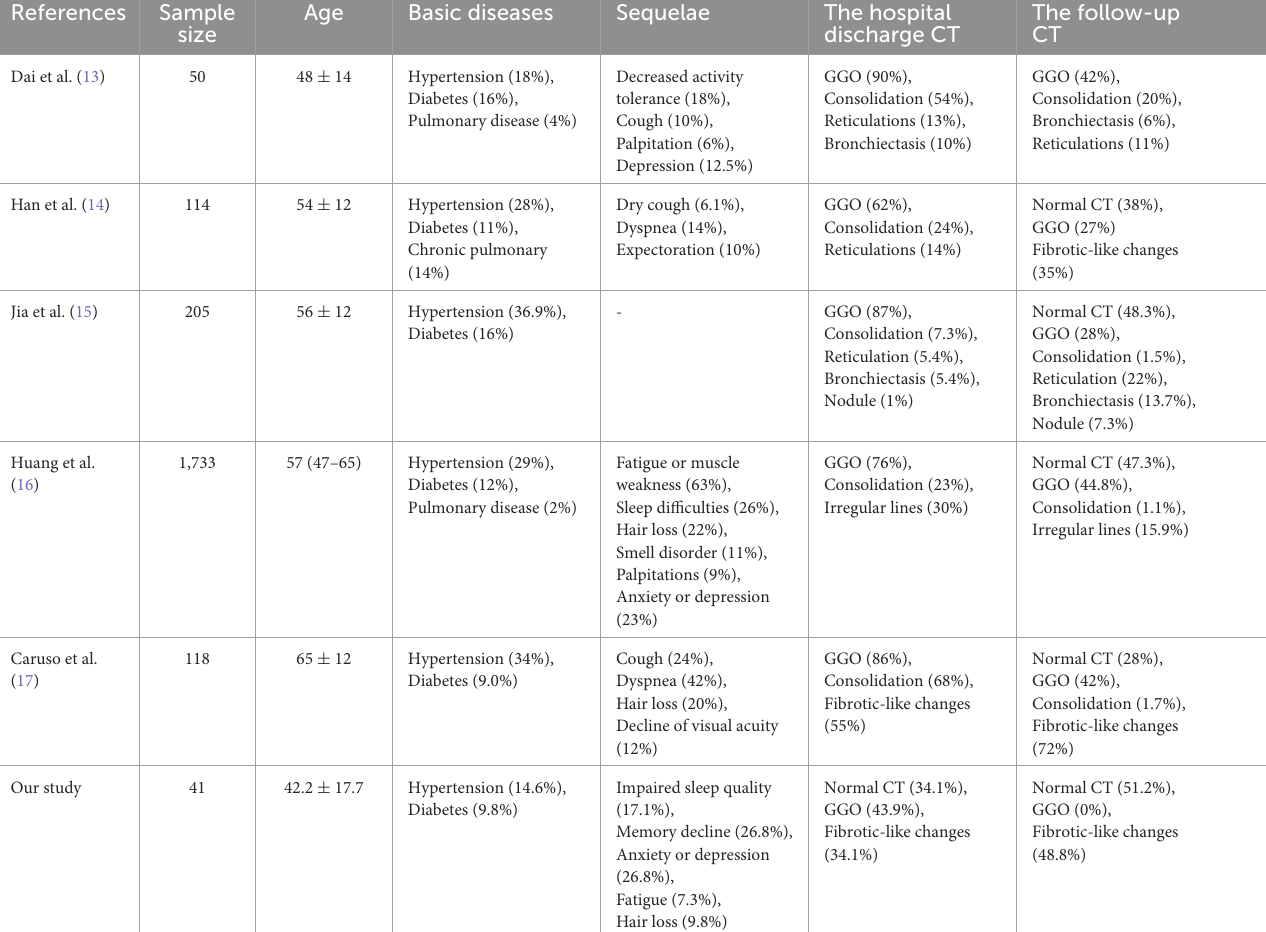
TABLE 4 Comparing the original COVID-19 follow-up to the Delta variant